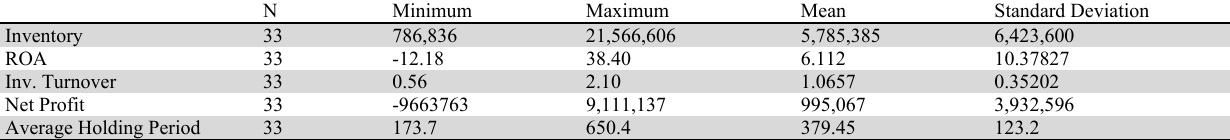
Descriptive Statistics for Inventory, Inventory Turnover, Net Profit, and ROA N